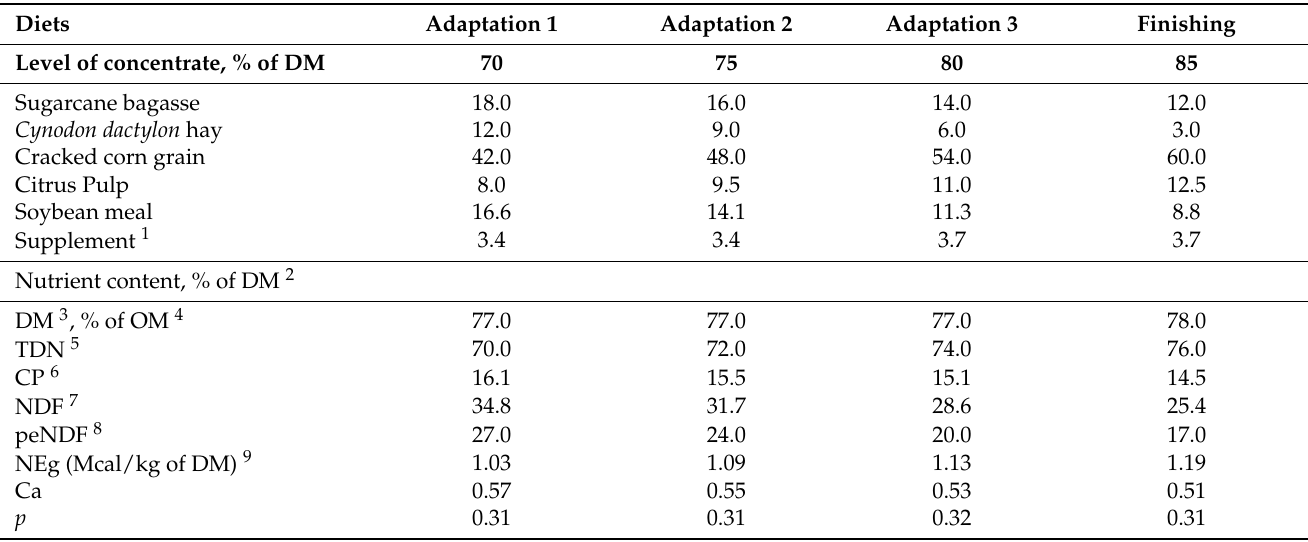
Table 1. Feed ingredients and chemical composition of the experimental high-concentrate diets offered for all RFI-groups of Nellore yearling bulls ( n =